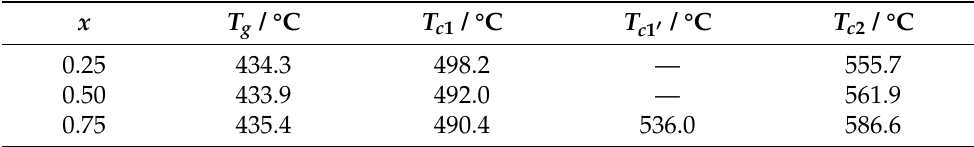
Table 2. Glass transition ( T g ) and crystallisation ( T c ) temperatures in the studied glassy samples, determined from DTA measurements carried out with 10 °C/min heating rate in argon flow. © The Electrochemical Society. Reproduced from Ref. [12] by permission of IOP Publishing. All rights